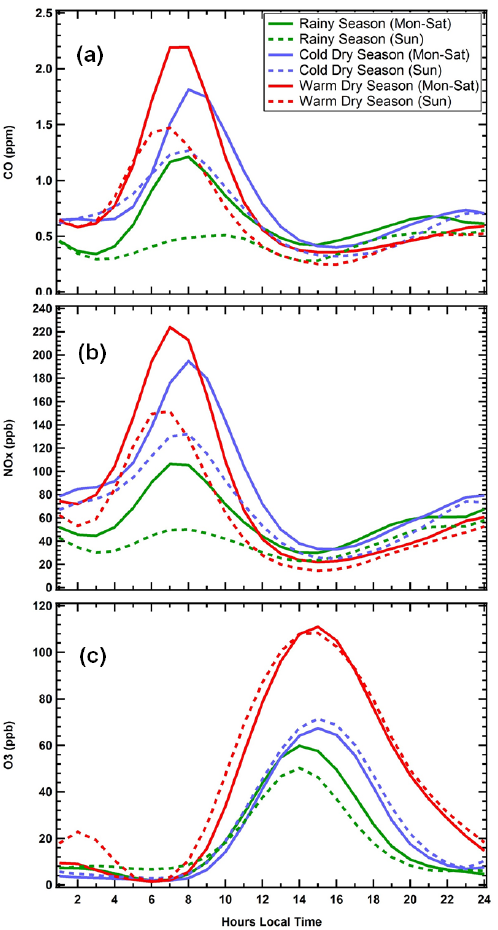
Figure 8. The average hourly values are shown, separated by work- day (solid) and weekend (dashed) and by season: warm-dry (red), rainy (green) and cold-dry (blue) for (a) CO, (b) NO x and (c) O 3